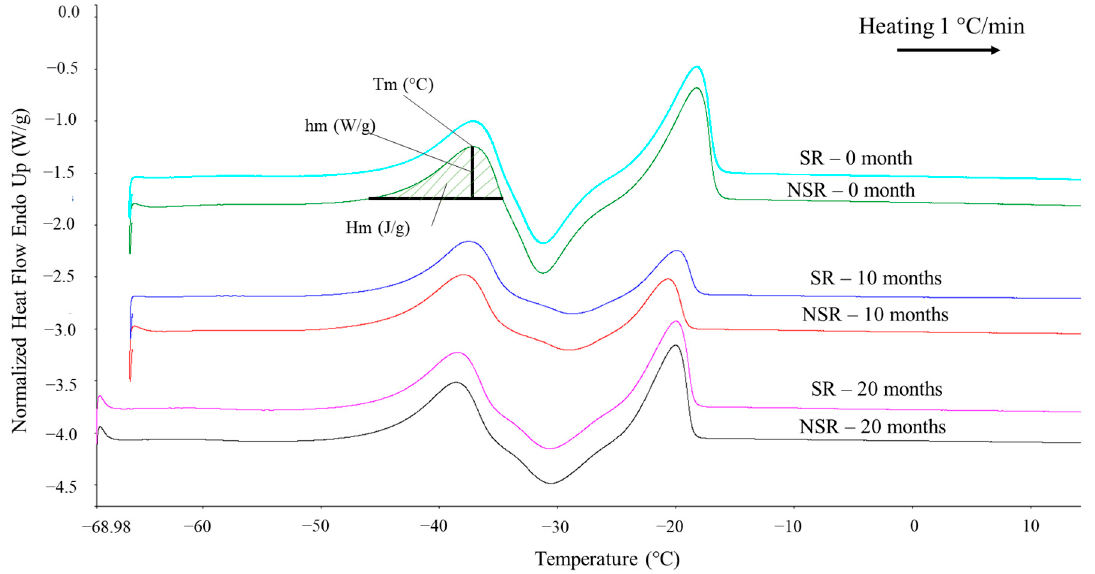
Figure 2. DSC melting curves of raspberry seed oil at scanning rate 1 °C/min. SR: oil not clarified, with seed residue, NSR: oil clarified, with no seed residue.